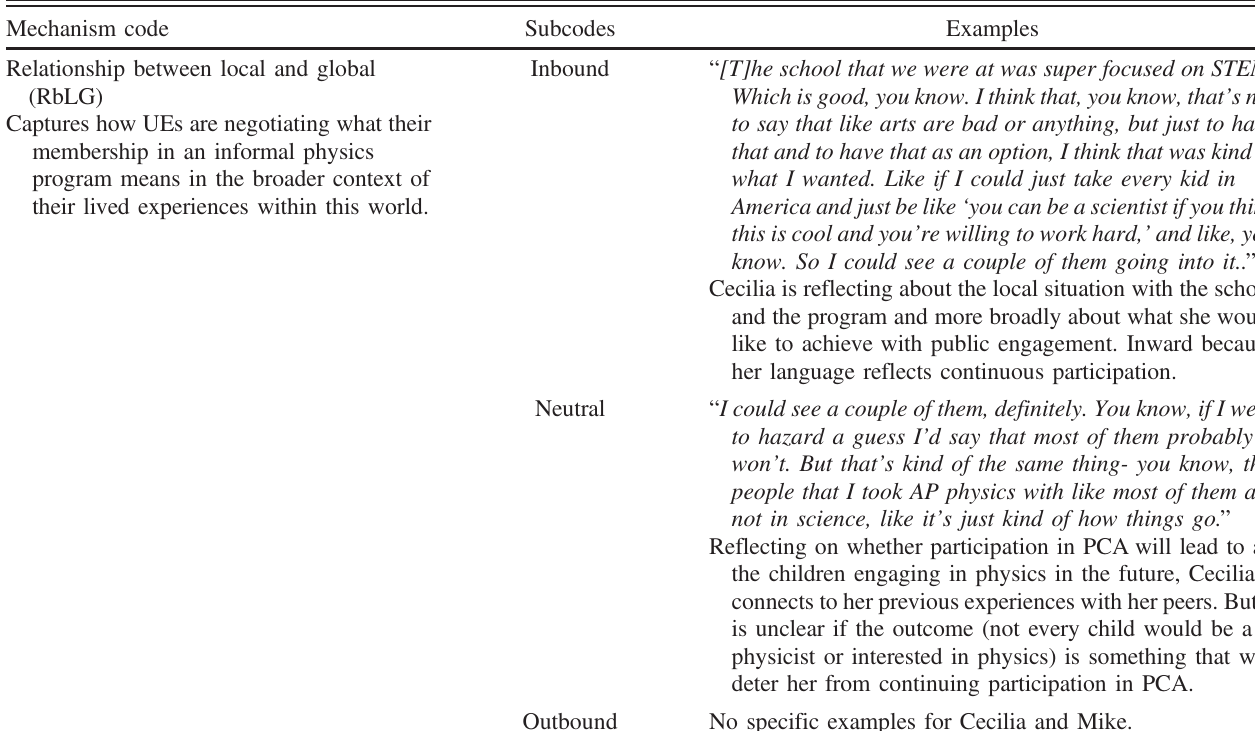
TABLE X. Examples and explanations for each subcode under the relationship between local and global construct.